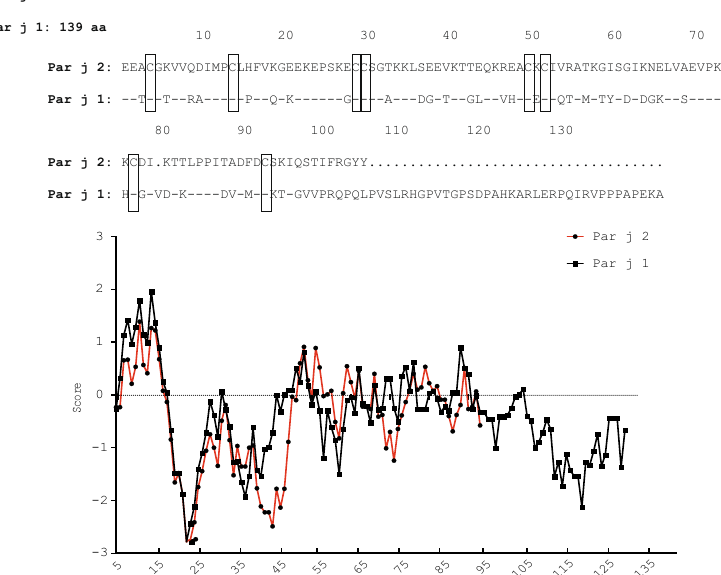
Figure 1. Alignment of the amino acid sequences of Par j 2 and Par j 1 (top) and hydrophobicity plots (bottom). Identical amino acids are indicated by dashes, dots indicate gaps and conserved cysteine residues are